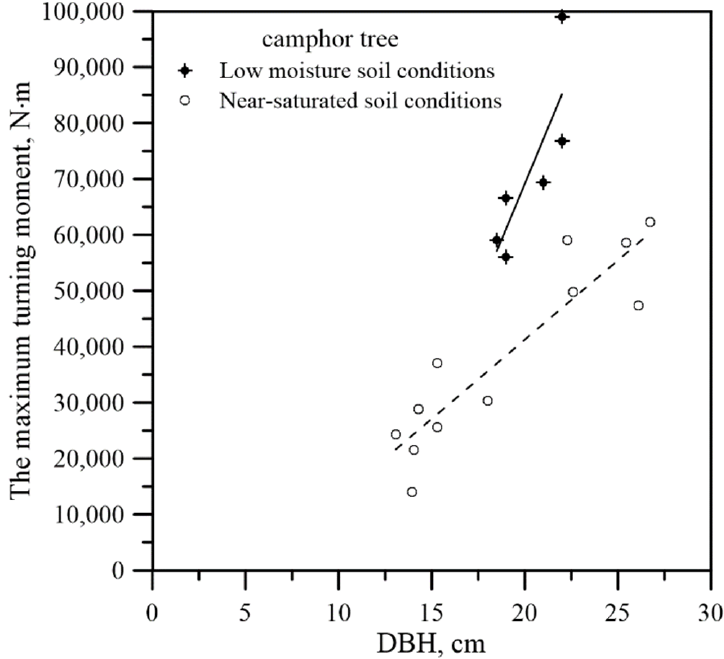
Figure 4. Maximum resisting moment vs. DBH for camphor trees in low-moisture and near-saturated soil conditions. Table 3. Regression equations for the relationship between TM max and DBH for camphor tree. In Low-Moisture Soil